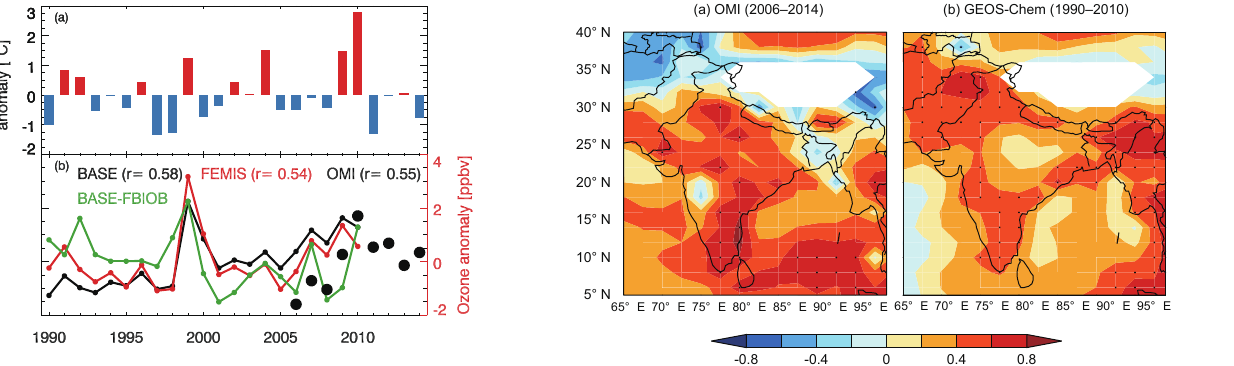
Figure 5. Time series of mean (a) surface temperature and (b) lower tropospheric ozone anomaly averaged for pre-summer monsoon seasons over the Indian terrestrial land. OMI observed ozone anomalies are shown by black circles, and model results from the BASE and FEMIS simulations are shown by black and red lines, respectively. The green line shows the ozone anomaly contributed by biomass burning emissions. Interannual correlation coefficients ( r ) between surface temperature and ozone (number of regional av- erages n = 9 for observations and 21 for model results) are shown in the inset.